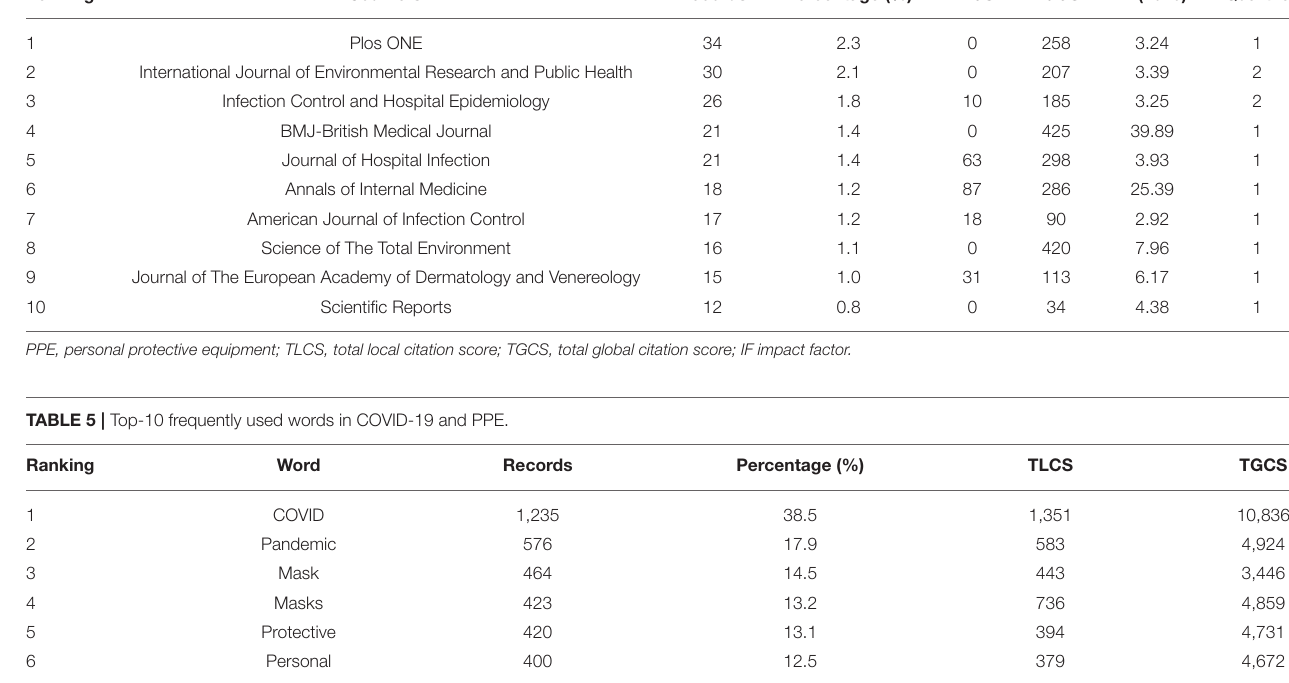
TABLE 4 | Top-10 leading journals in COVID-19 and PPE. Ranking